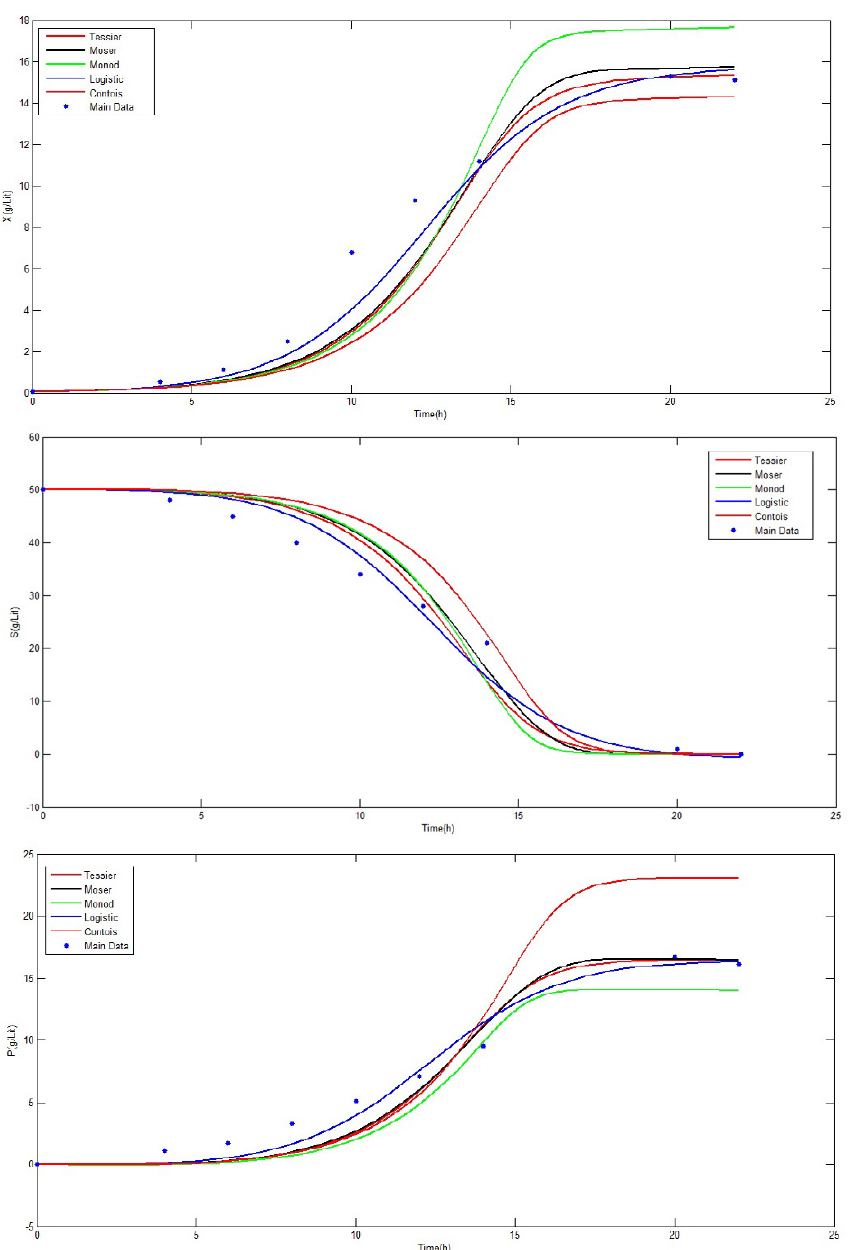
Fig. 7 . Fig. 7. Prediction of the different models for (a) microorganisms, (b) substrates and (c) biosorption product in batch membrane re-